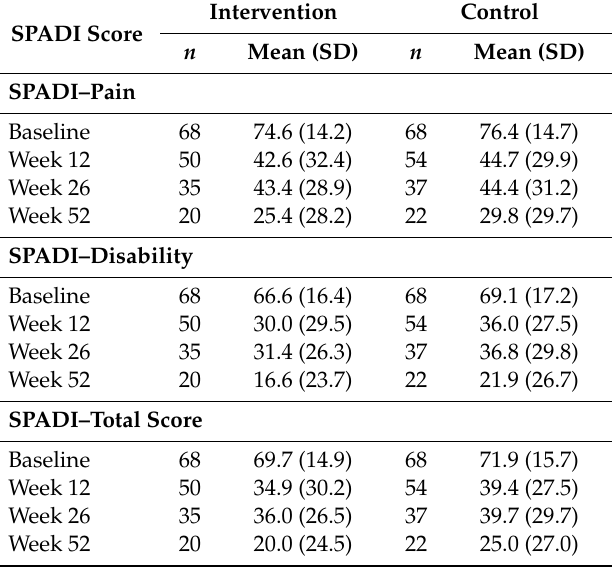
Table 3. Shoulder pain and disability index (SPADI) results–pain, disability and total score.